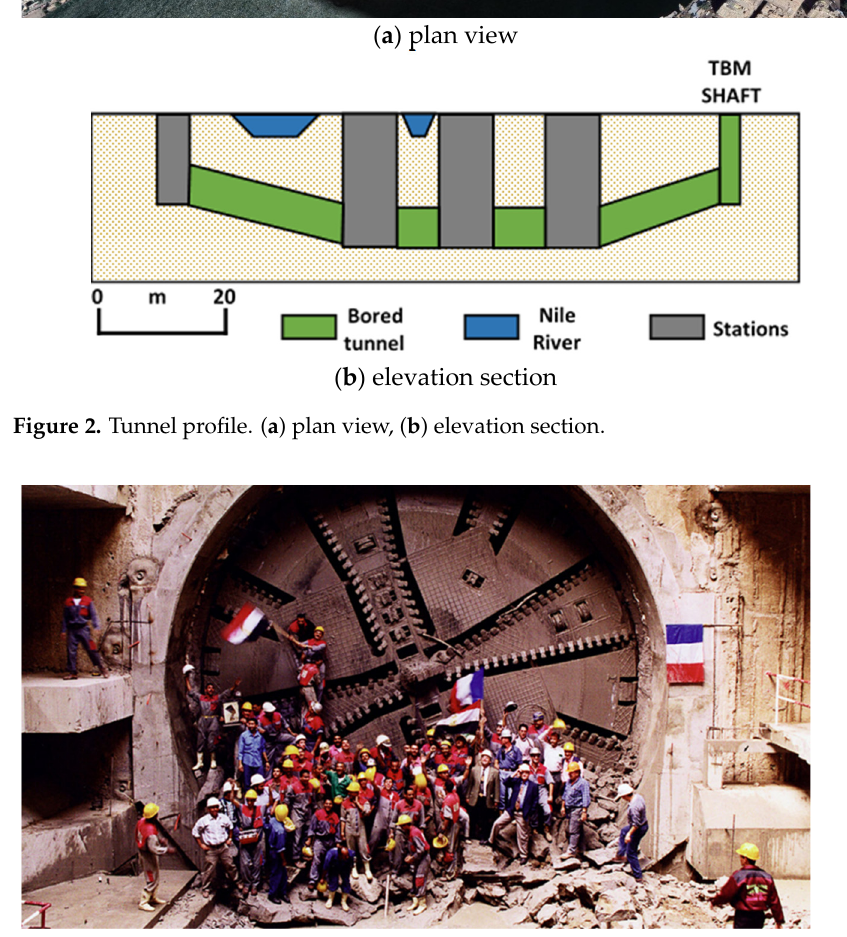
Figure 3. One of the TBMs on the last day of drilling the Line 2 tunnel.